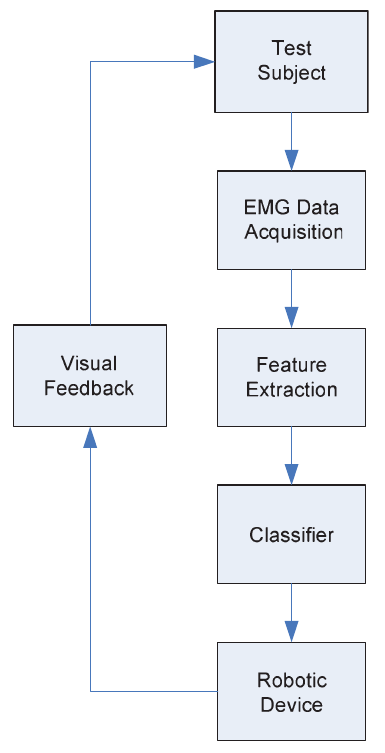
Fig. 1. Typical myoelectric control scheme based on pattern